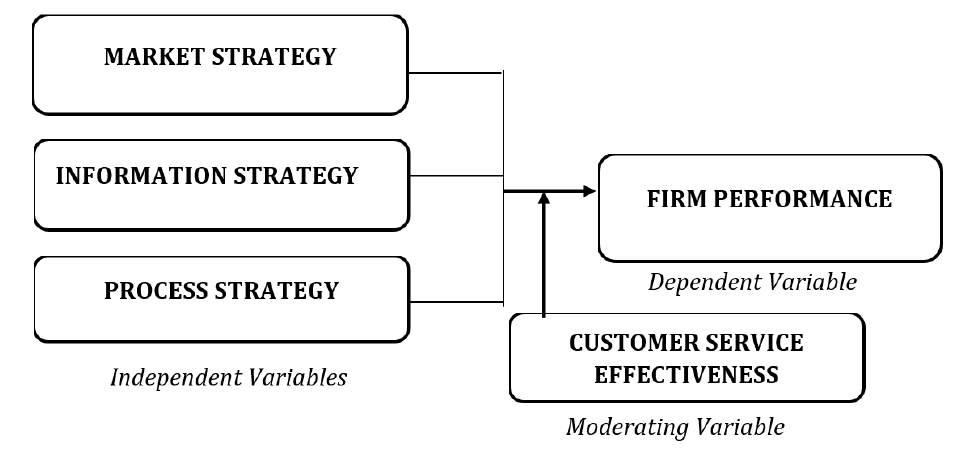
Figure 1: Suggested cause and effect